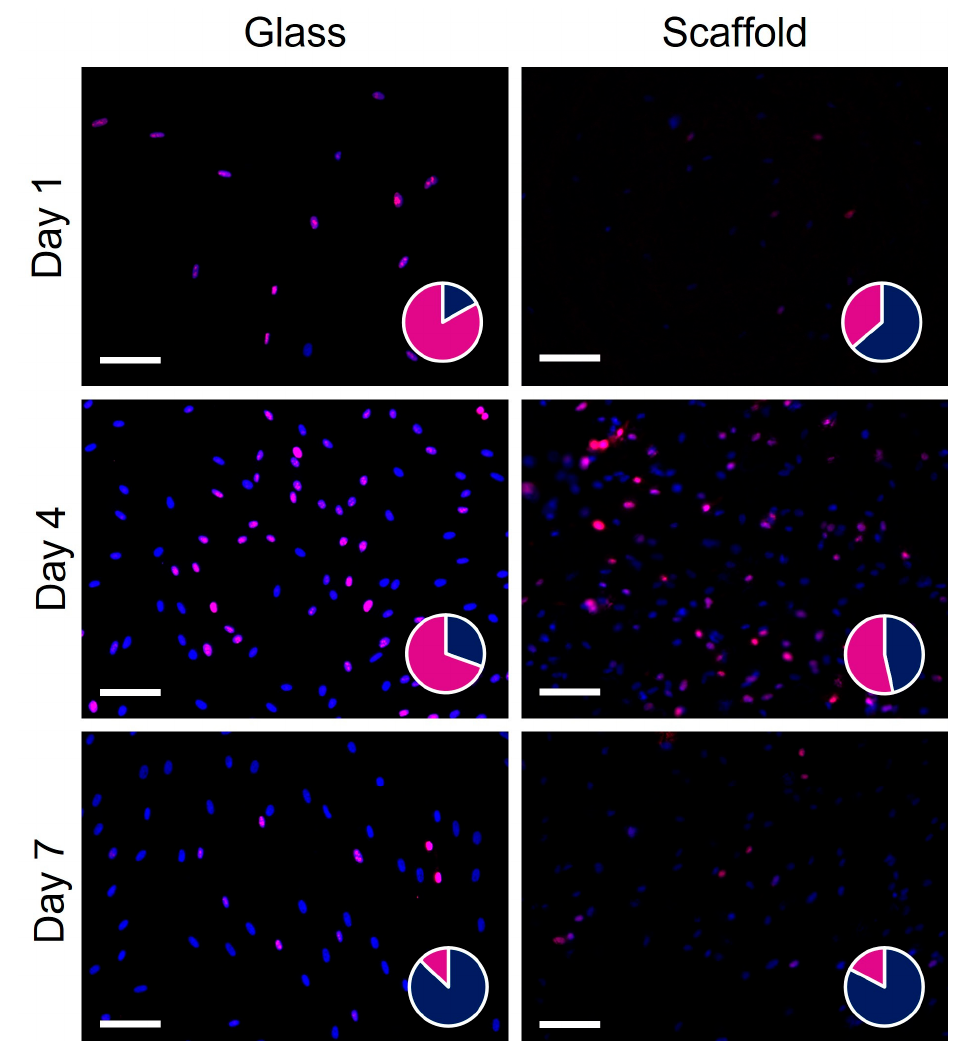
Figure 5. Representative Ki67 immunofluorescent images. The same image enhancement using ImageJ software to subtract background fluorescence and increase brightness was used for all images. Ki67 expressing NOFs were visualized with a CY3 conjugated secondary antibody and appeared purple in the merged images. All cell nuclei were counter stained with DAPI. Superimposed pie- charts show the proportion of cells which were proliferative (Ki67+/DAPI+) in purple and the proportion that were quiescent (Ki67-/DAPI+) in blue. Pie charts were generated after counting all the cell nuclei from 3 randomly positioned images taken from 3 technical replicates from each of the 3 biological replicates for a total of 27 images per time point. Scale bar (white) is equal to 100 μ m.